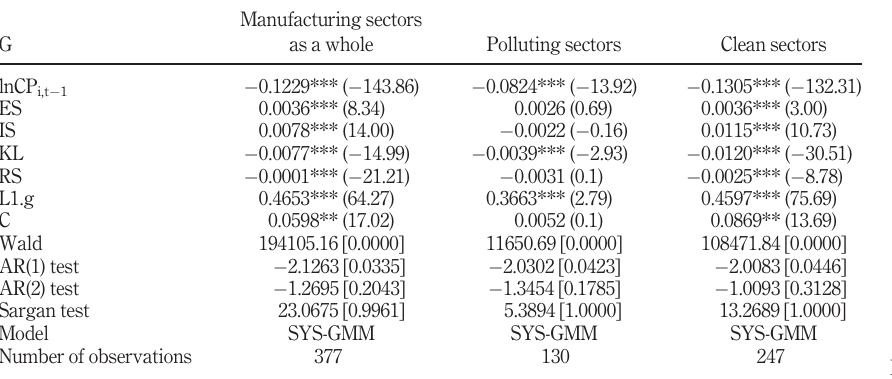
Table 5. Estimated results